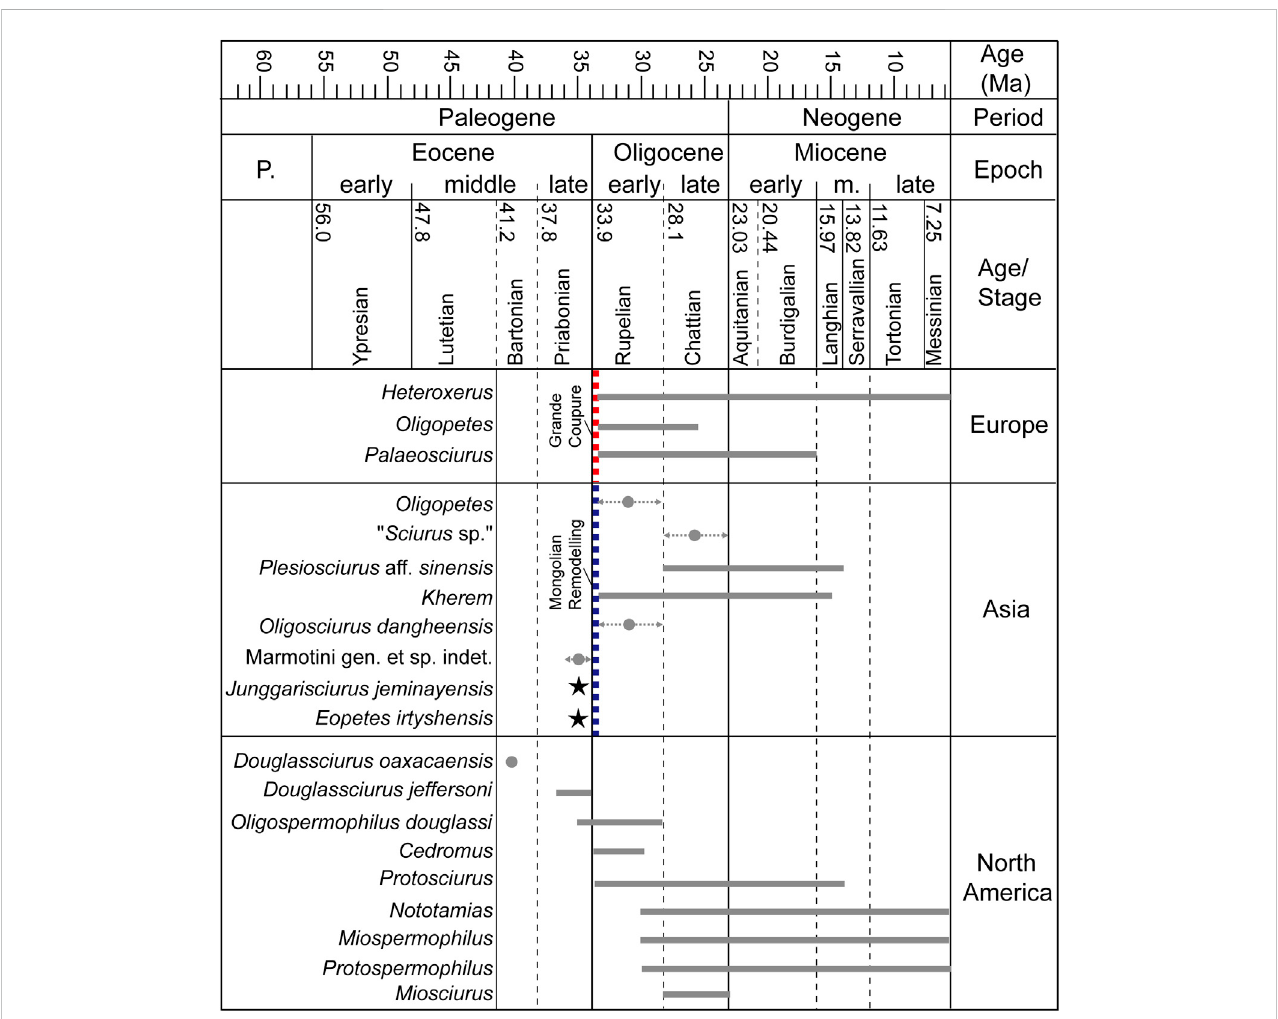
FIGURE 4 Chronologic ranges of Eocene to Oligocene sciurids from North America, Asia, and Europe. The fossil records of sciurids span the Eocene/Oligocene boundary in both North America and Asia but appear later in the early Oligocene of Europe. Douglassciurus oaxacaensis is the earliest member of sciurids in late middle Eocene , Junggarisciurus jeminaiensis , Eopetes irtyshensis , Douglassciurus jeffersoni, and Oligospermophilus douglassi form the second earliest con fi dent records of sciurids in the late Eocene. Red dashed line, Grande Coupure; blue dashed line, Mongolian Remodelling; gray dot with dashed arrowed line,estimateddate;asterisks, J.jeminaiensis and E.irtyshensis fromJeminay, northwesternXinjiang, China.Abbreviations: P .,Paleogene; m.,middle